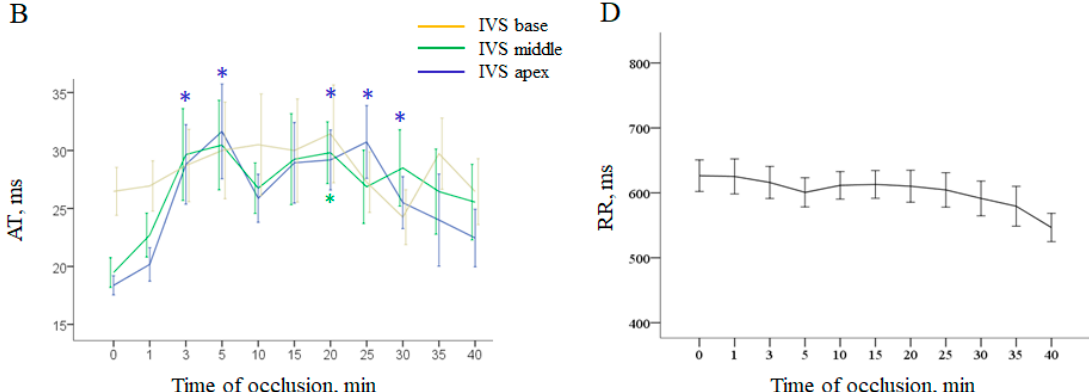
Figure 1. Ischemia-related changes of ventricular depolarization parameters (mean ± SEM). Panels ( A , B ) show local activation times (AT) in the left ventricular (LV) wall and interventricular septum (IVS), respectively. Panel ( C ) shows dynamics of maximal AT throughout all intramyocardial leads.RR dynamics are presented in panel ( D ). * denotes statistically significant differences in respect to baseline (0 min). See the most pronounced changes in the apical regions of the LV wall and IVS and less pronounced changes in the middle part of IVS. In the combined group (control + melatonin) basal regions do not demonstrate significant changes during occlusion. See a “spike and dome” pattern of maximal AT dynamics with two maxima at 3–5 and 15–30 min. more (Figure 2). Activa- tion-repolarization intervals (ARIs) shortened in the ischemic regions and stayed rela- tively stable in the normal and border regions (Figure 2A,B). As the minimal ARI dura- tion characteristic of deeply affected ischemic regions decrease during occlusion, and the maximal ARI duration observed in the normal regions was unchanged, dispersion of repolarization (DOR) progressively increased (Figure 2C).